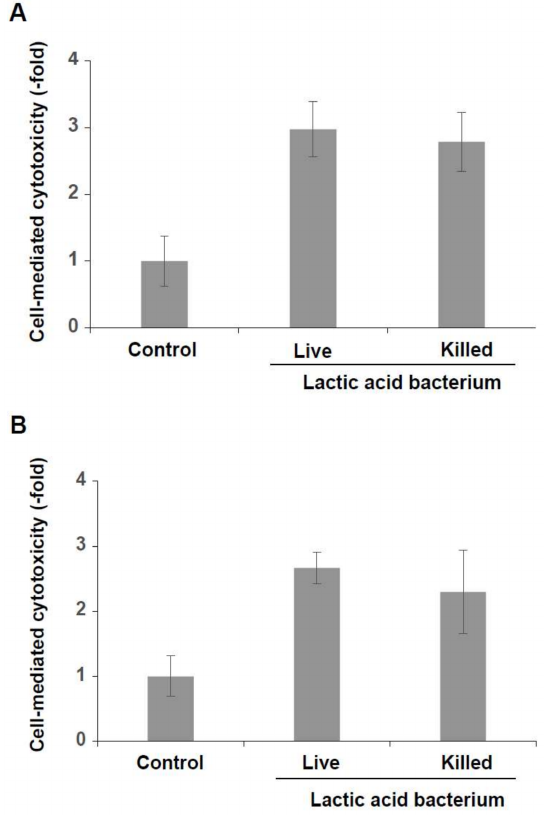
Figure 4. Induction of cell-mediated cytotoxicity of KHYG-1 cells by the live and the killed lactic acid bacteria mixtures. KHYG-1 cells were treated with both mixtures (3 × 10 4 cfu) for 24 h at 37 ◦ C in a 5% CO 2 incubator. The treated cells were reacted with K562 cells ( A ) or with HCT116 cells ( B ) for 4 h at 37 ◦ C in a 5% CO 2 incubator. In both cases, cell-mediated cytotoxicity was increased in KHYG-1 cells that had been treated with both the live and the killed lactic acid bacteria